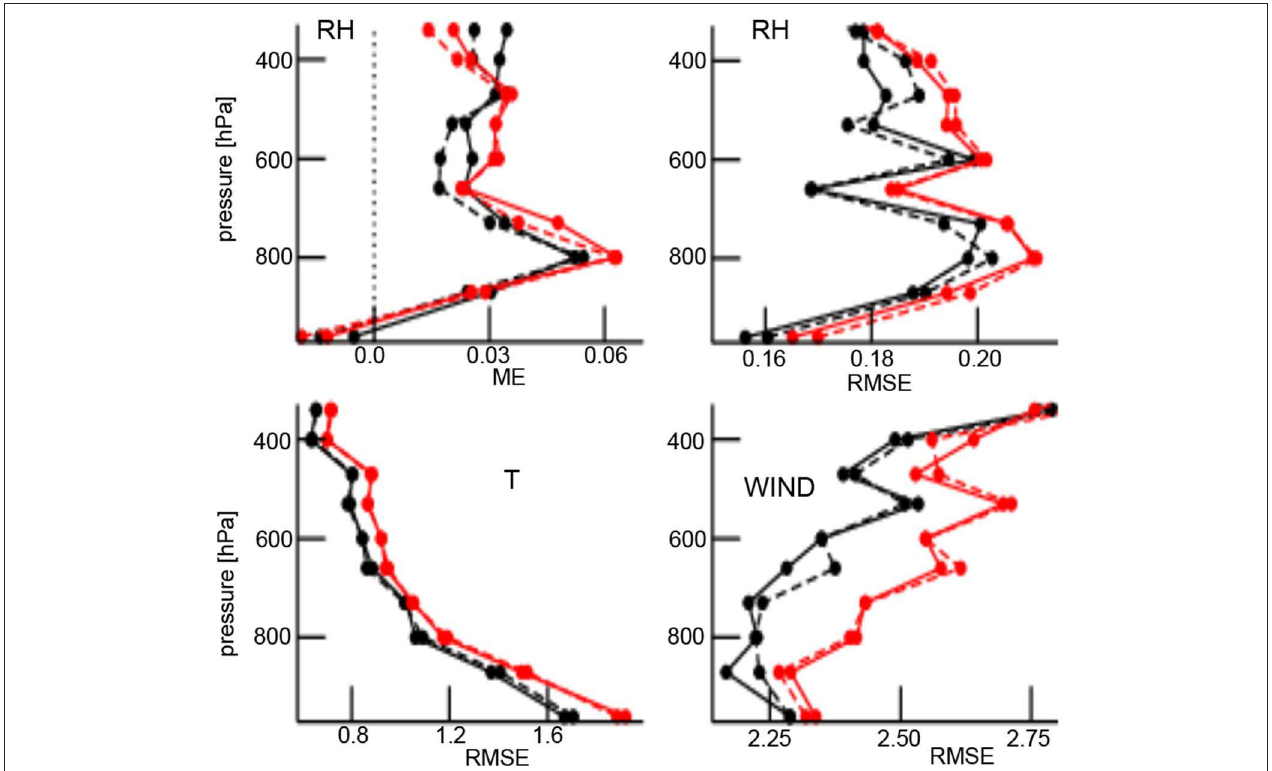
FIGURE 13 | Forecast mean error (ME) of relative humidity and root-mean square error (RMSE) of relative humidity, temperature and wind speed vs. radiosondes for different lead times, all initial times and experiments in winter period 2016. Black and red lines denote forecast lead time 6 and 12 h, respectively; dashed lines and solid lines represent NO-SEVIRI and SEVIRI-NEW experiment, respectively. All forecast statistics consider the same observations distributed over the model domain.